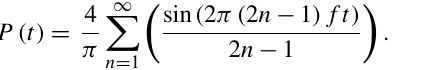
Figure 3. Software GUI in multi-channel